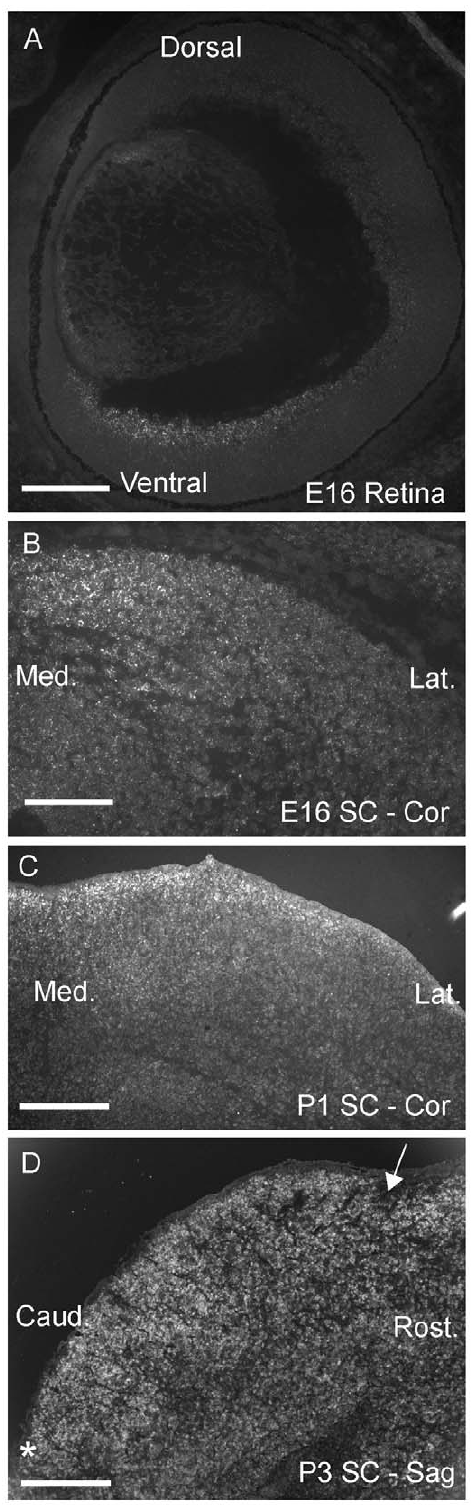
Figure 3. Ten-m3 is expressed in topographically correspond- ing gradients in the retina and SC. A: In situ hybridisation for Ten- m3 on a coronal section through the retina of an E16 mouse. Expression shows a high-ventral to low-dorsal distribution in the developing RGC layer. B–C: In situ hybridisation for Ten-m3 in coronal sections through the SC at E16 (B) and P1 (C). Expression shows a high medial to